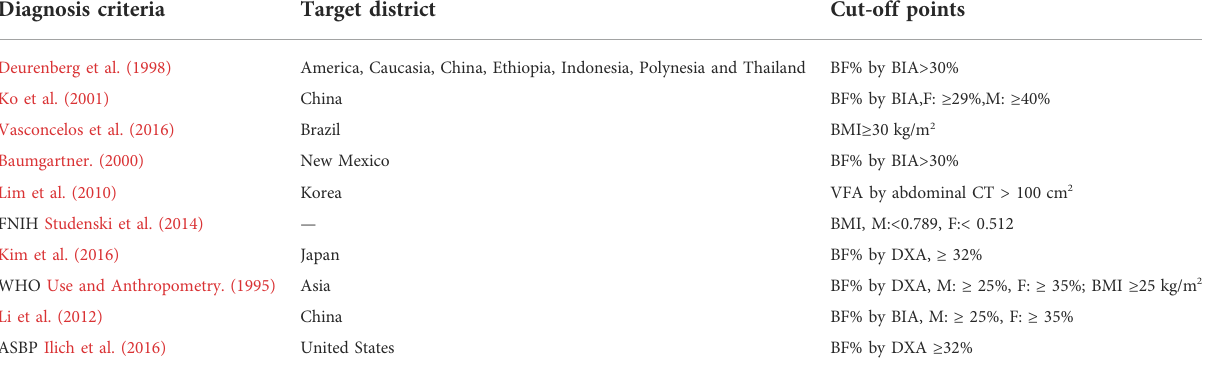
TABLE 3 Different indicators and cut-off points in de fi ning